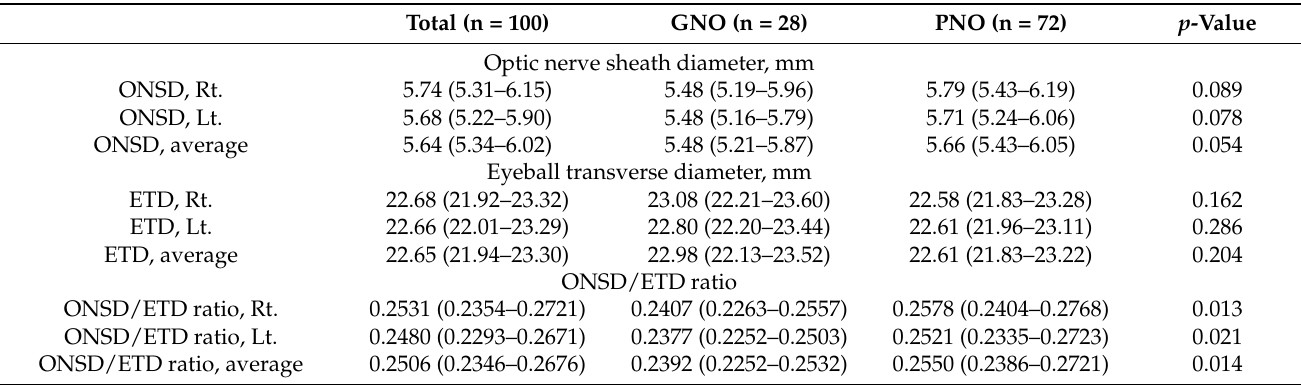
Table 2. Comparison of the ONSD/ETD ratio between good and poor neurologic outcomes. Total (n = 100) GNO (n = 28) PNO (n = 72) p -Value Optic nerve sheath diameter, mm